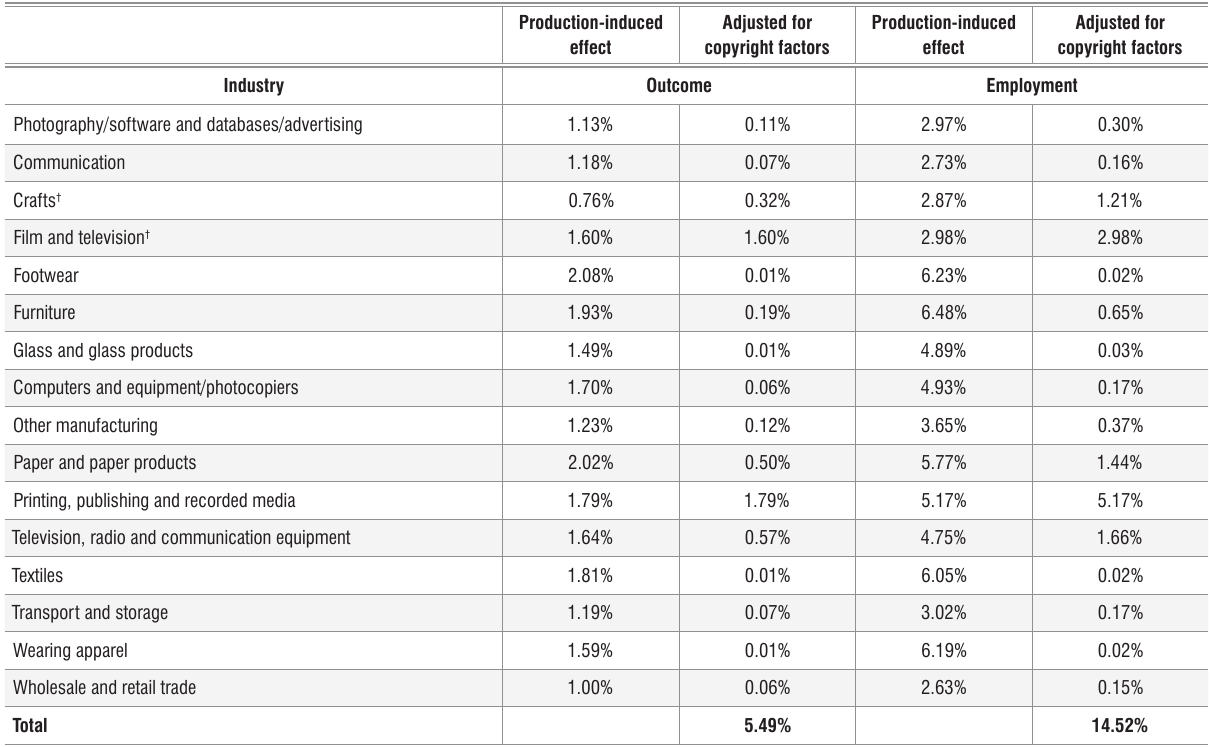
Production-induced effect of copyright-based industries: Results of an input-output analysis of 2009